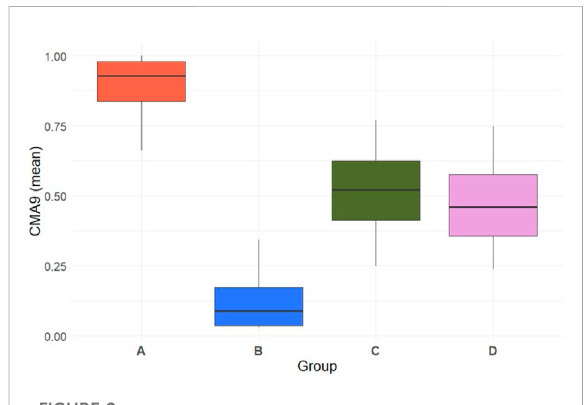
FIGURE 3 Predictors of inclusion in the poor adherence (group B), occasional use (group C) and gradual decline (group D) groups in relation to the high adherence group (group A). Multinomial